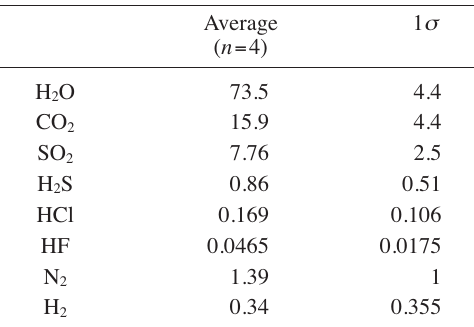
Table I. Recalculated compositions of Lewotolo gas samples in mol% (after Poorter et al. , 1991).